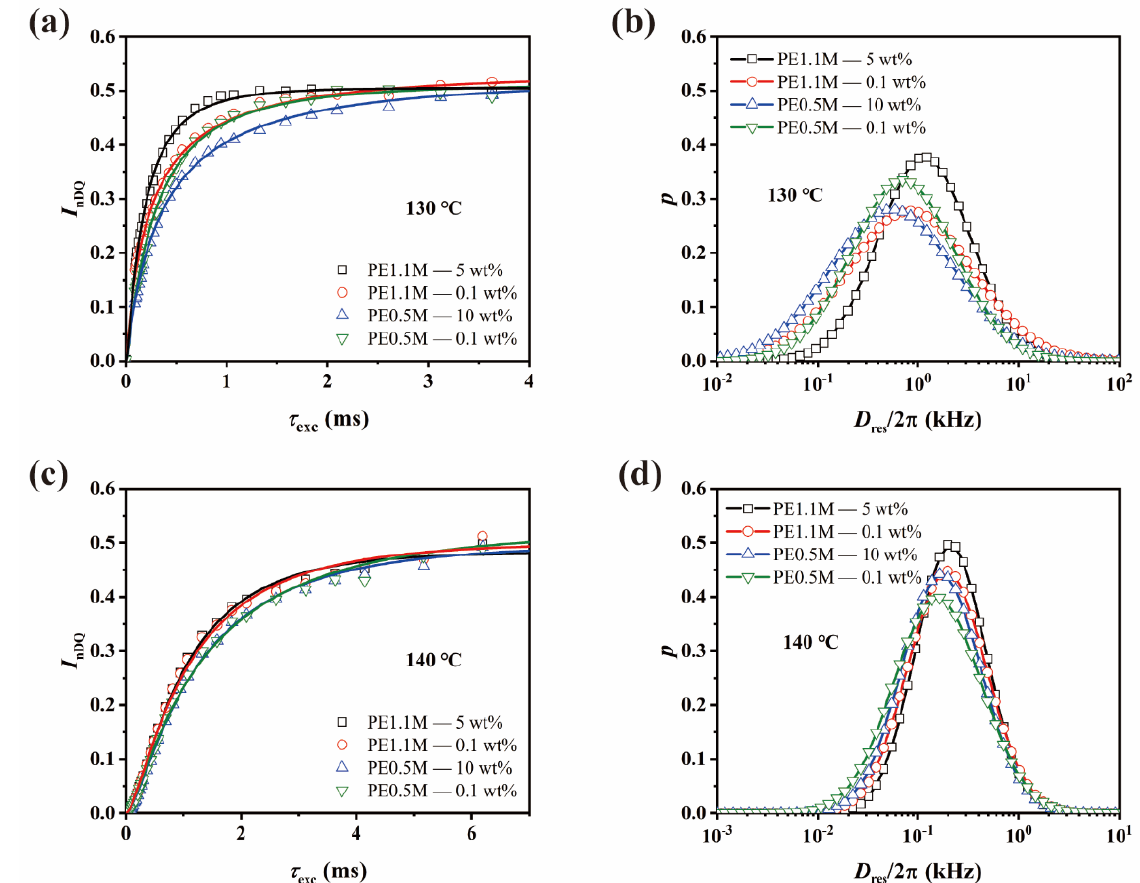
Figure 7. nDQ curves and D res distribution of all the PE samples at ( a , b ): 130 °C and ( c , d ): 140 °C. The solid lines in ( a ) and ( c ) represent fitting curves of I nDQ . For 120 °C and 190 °C, please refer to Figure S5 (see in Supplementary Materials).